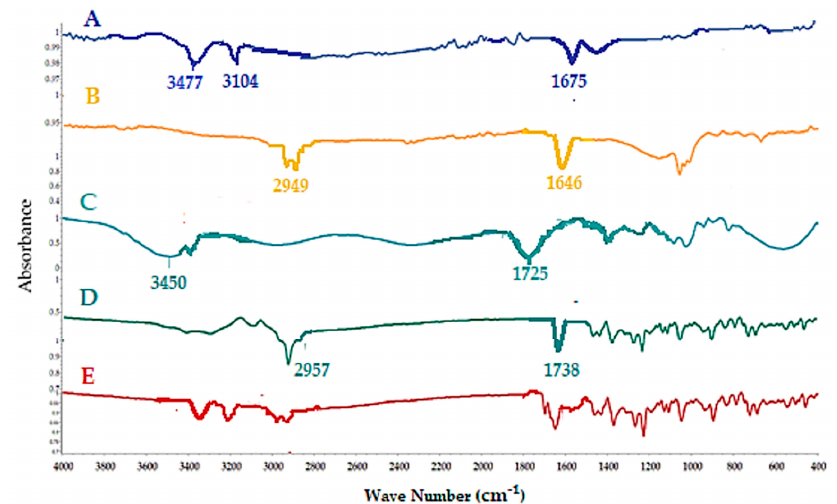
Figure 1. FTIR spectra of pure TLM ( A ); pure CP ( B ); pure CCS ( C ); pure camphor ( D ) and physical mixtures TLM/all excipients ( E ).